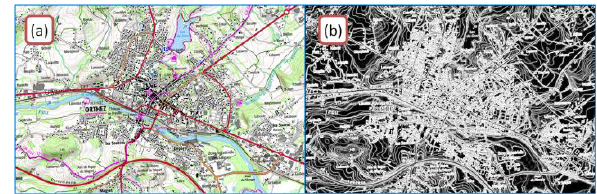
Figure 3. (a) Topographic map at 1:25k. (b) edges of the map (in white) Figure 5. (a) map extracts from past generalization experiments. (b) maps at different scales extracted from official geoportal All four clutter measures have been implemented in the open source Java platform Geoxygene (Bucher et al., 2012). The segmentation and edge detection implementations are based on the OpenIMAJ library (Hare et al., 2011).